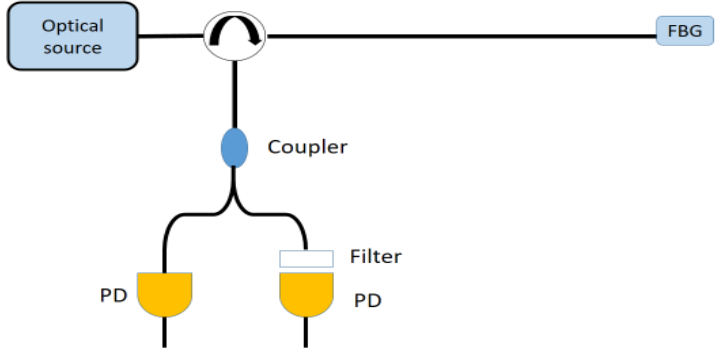
Figure 15. Example of experimental set-up for passive edge filtering interrogation technique with reference signal measurement.